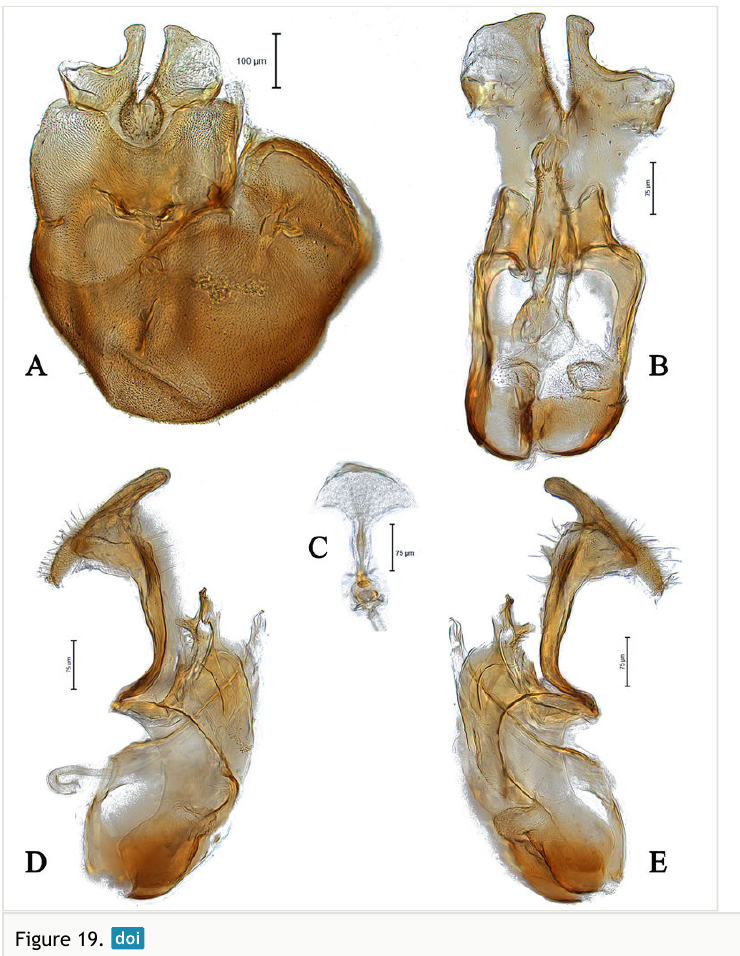
Figure 19. Male genitalia of Eudorylas obliquus (JSS50762) (A) in dorsal view; (B) in ventral view; (C) ejaculatory apodeme; (D, E) in lateral